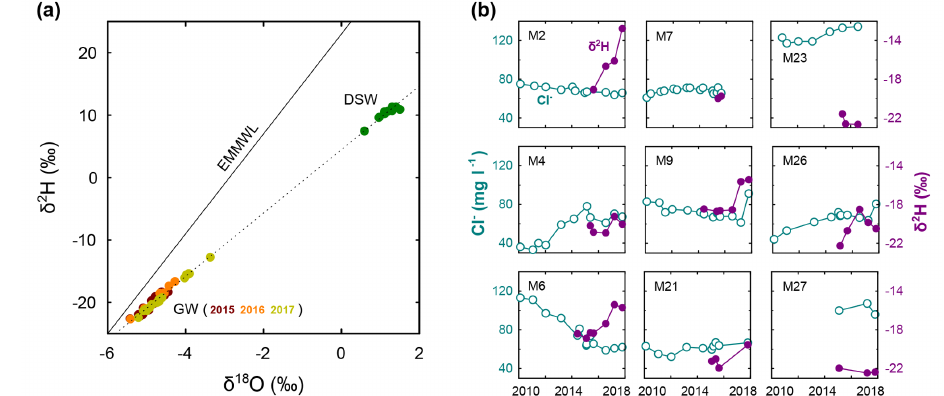
Figure 3. (a) Water isotopic composition of the production wells (GW) and reverse-osmosis desalinated seawater (DSW); the eastern Mediterranean meteoric water line (EMMWL) is shown for comparison (Gat and Dansgaard, 1972). (b) Chloride (Cl − ) and δ 2 H sampled in nine production wells at the Menashe MAR site.